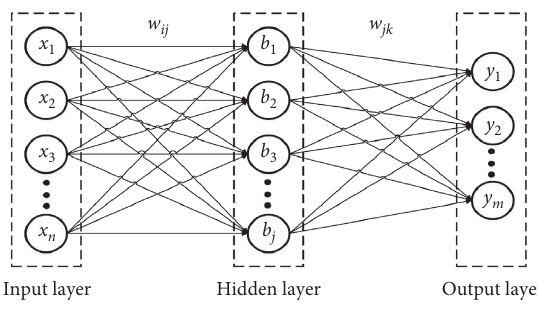
Figure 8: Diagram of